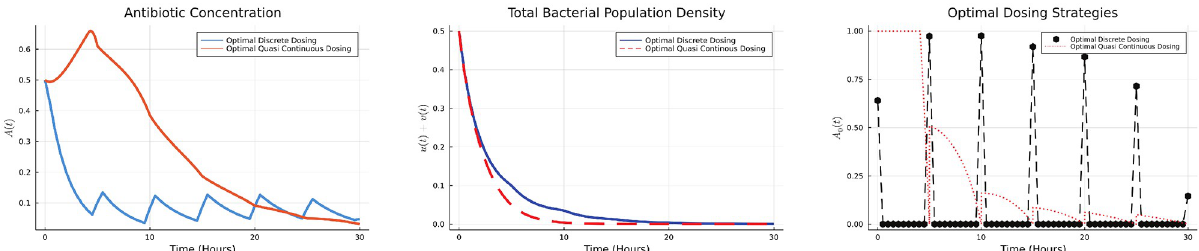
Fig 10. Optimal dosing strategies, bacterial population, and antibiotic